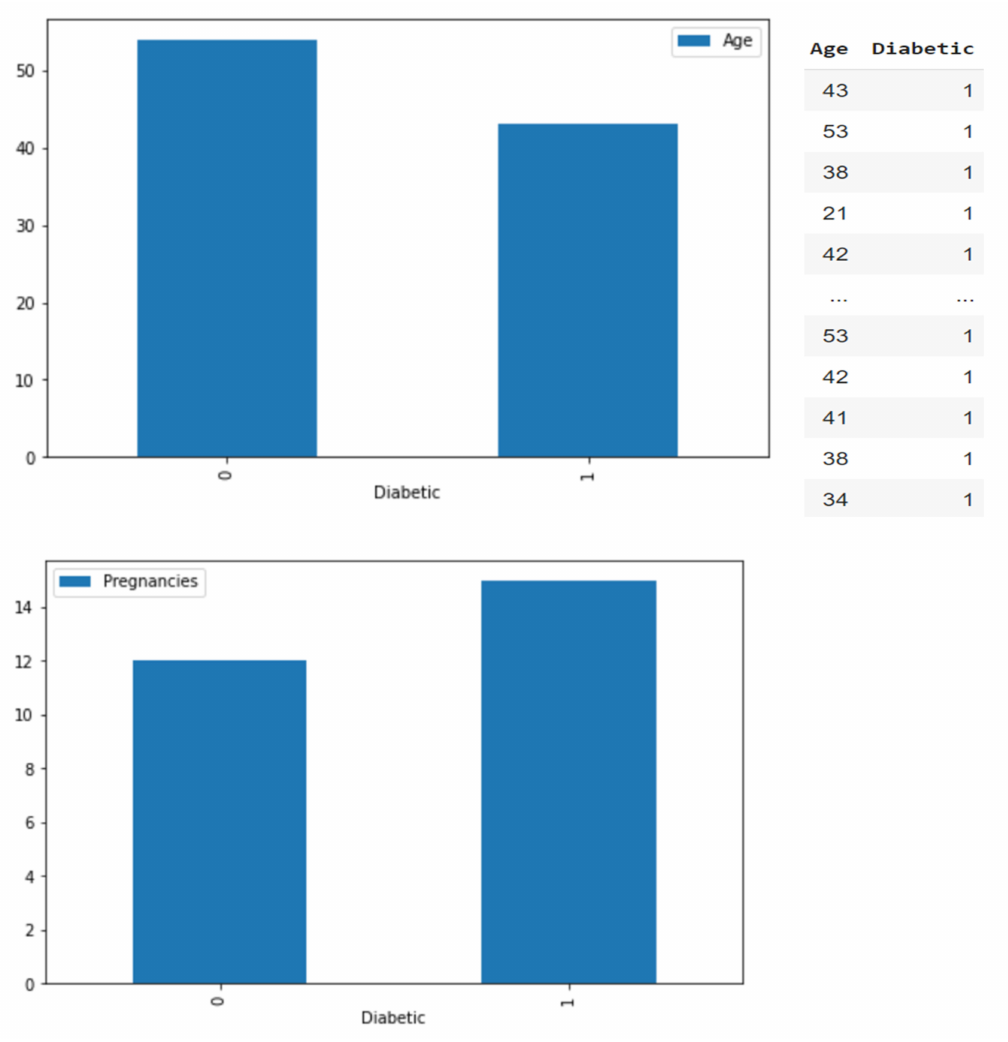
Figure 3. Diabetic/non-diabetic